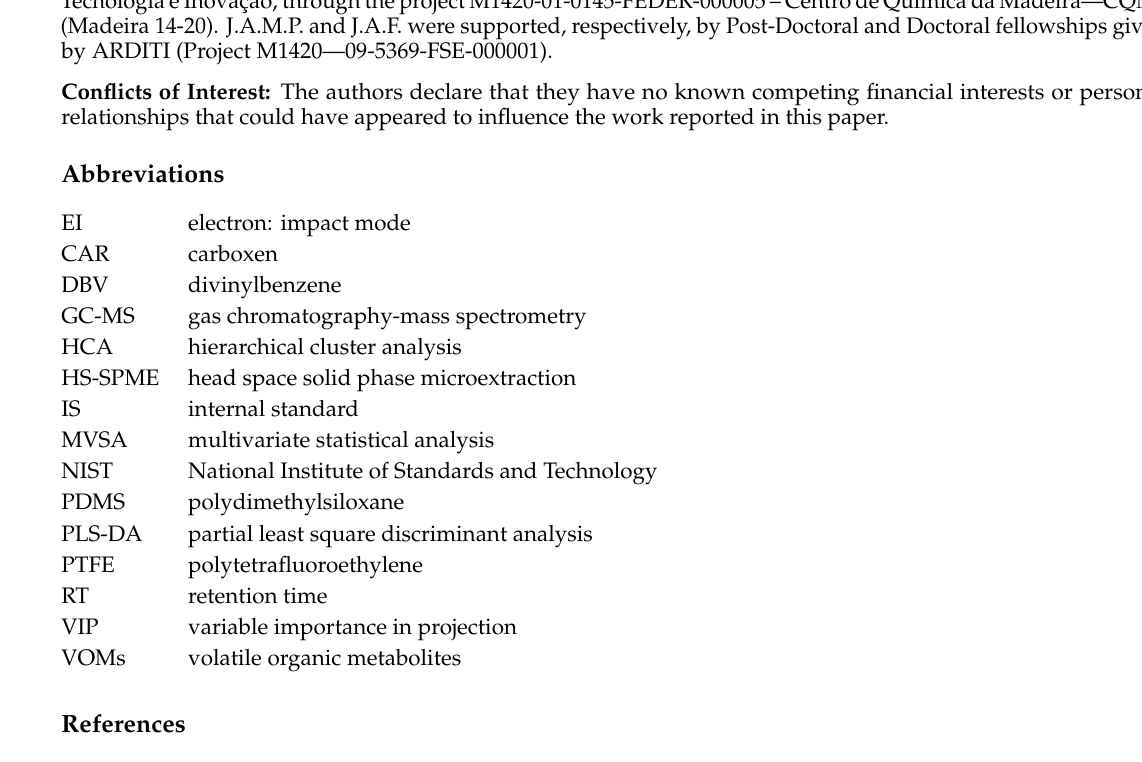
Supplementary Table S1: Volatile organic metabolites (VOMs) identified in tangerines juices and peels from the setubalense and murcott varieties; Supplementary Table S2: VOM identified by One-way ANOVA and post hoc analysis, found as statistically significant for p <